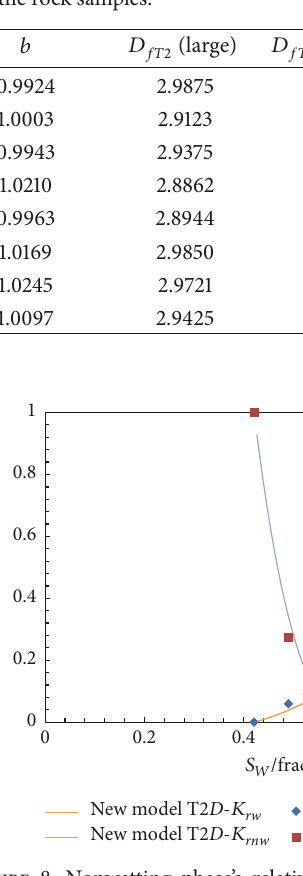
Table 1: Basic information of the rock samples.